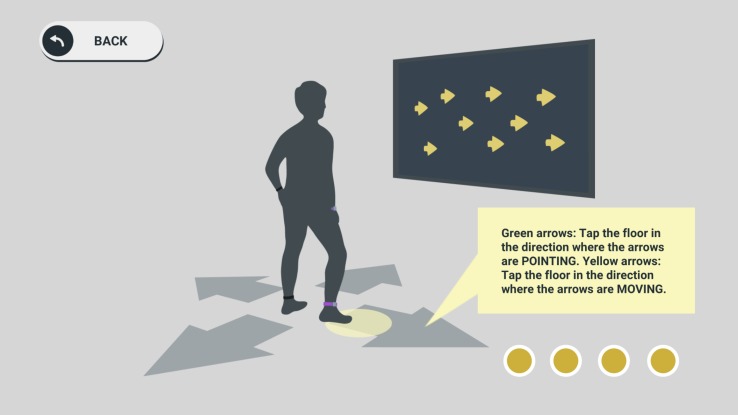
Step-based cognitive training. The Active@Home exergame included step-based exercises to train specific cognitive functions (a task for inhibition training is shown in the picture). By stepping forward, backward, and to the right or left side, these games were played and controlled. The IMUs worn at ankles evaluated the stepping performance.